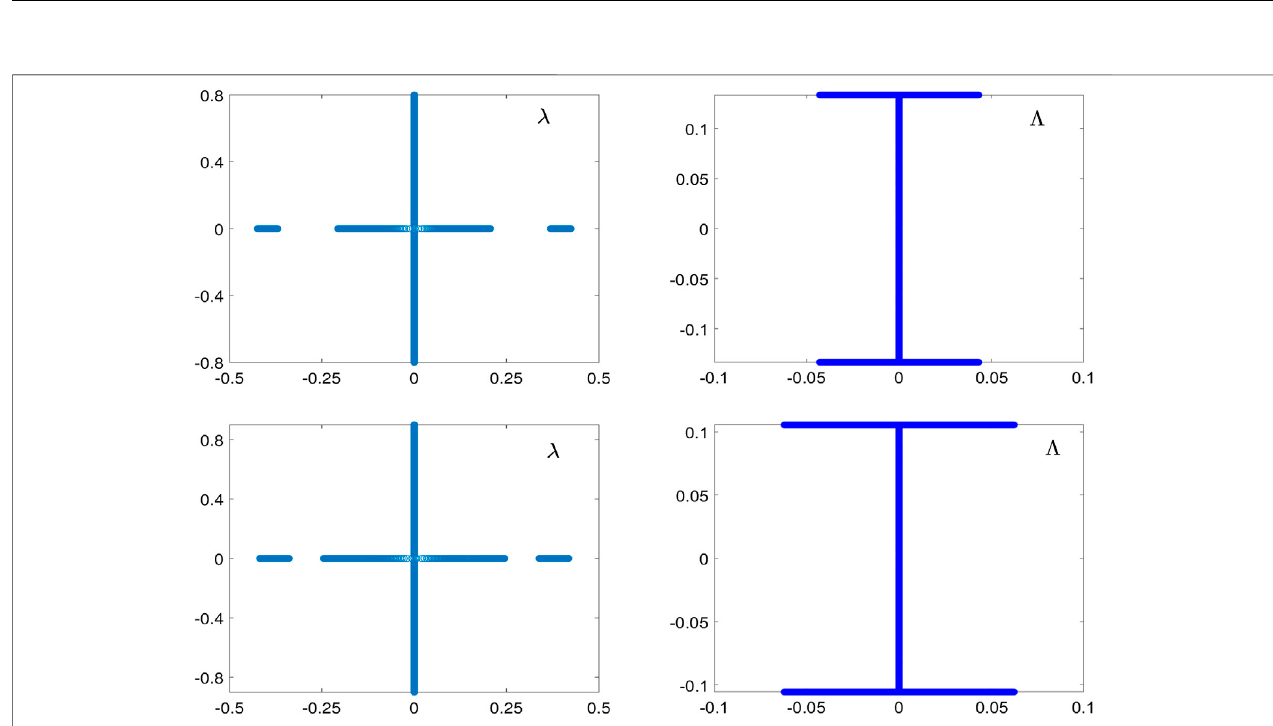
shown on left panels of Figure 3 for k (cid:2) 0 . 85 (top) and k (cid:2) 0 . 95 (bottom). The unstable spectrum on the Λ -plane is obtained from the same expressions Λ (cid:2) ± 2 i traverses along the bands of the Lax spectrum outside i R . The unstable spectrum resembles the fi gure-eight band as is shown on the right panels of Figure 3 . The fi gure-eight band starts and ends at Ω (cid:2) 0 for λ (cid:2) λ 1 and λ (cid:2) λ 2 . Stability spectrum for both examples is similar in spite of the differences in the Lax spectrum. The only difference is that the fi gure-eight band and the purely imaginary bands intersect for k (cid:2) 0 . 85 (top) and do not intersect for k (cid:2) 0 . 95 (bottom). Thus, the cn-periodic wave Eq. 2.12 is spectrally and modulationally unstable. As k → 1, the fi gure-eight band shrinks to an eigenvalue at the origin.